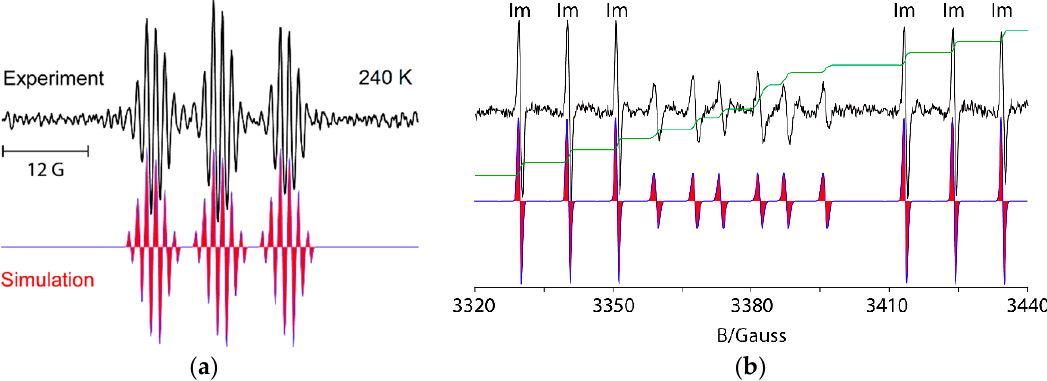
Figure 1. 9 GHz isotropic EPR spectra of selected iminyl radicals in t -butylbenzene solution. Left top ( a ) Experimental spectrum of 1-phenylpropan-2-yliminyl radical 9 , with simulation below ( red ), during UV photolysis of dioxime oxalate 4a . Right top ( b ) Experimental spectrum during UV photolysis of oxime ester 3a at 320 K showing iminyl radical 11 (marked Im ) in black with simulation in red ( below ) and double integral in green. The spectrum of adduct oxyaminyl radical 12 appears in the central region.